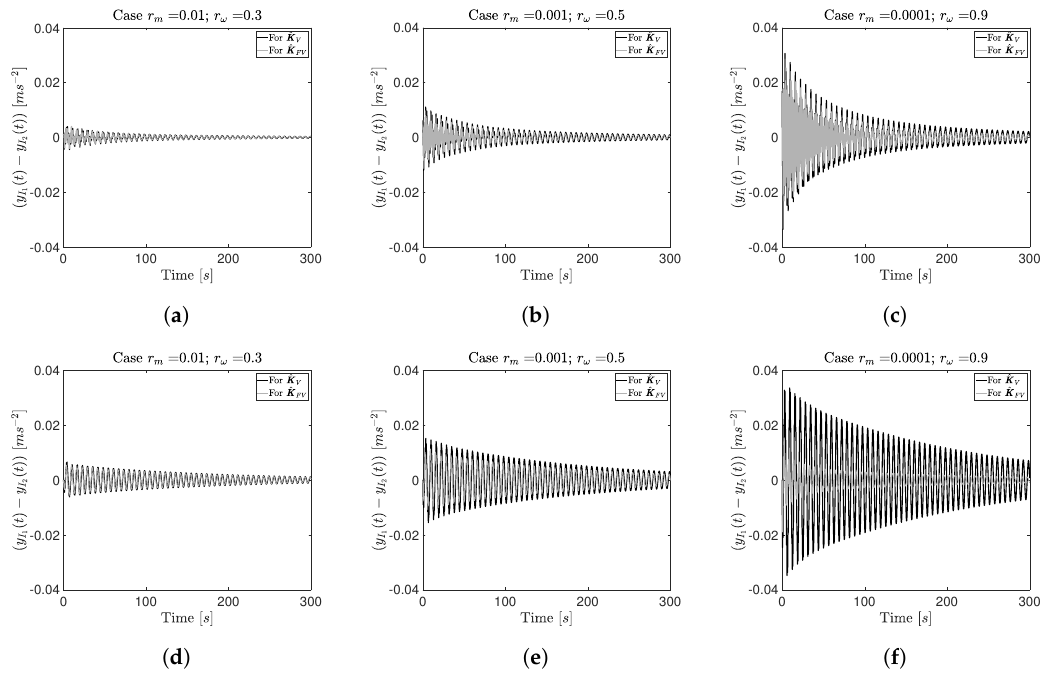
Figure 7. Impulse responses for three particular cases: ( r m = 0.01, r ω = 0.3 ) ( a , d ); ( r m = 0.001, r ω = 0.5 ) ( b , e ); and ( r m = 0.0001, r ω = 0.9 ) ( c , f ), for a single disturbance input ( top row ) and three disturbance inputs for the symmetrical case ( bottom row